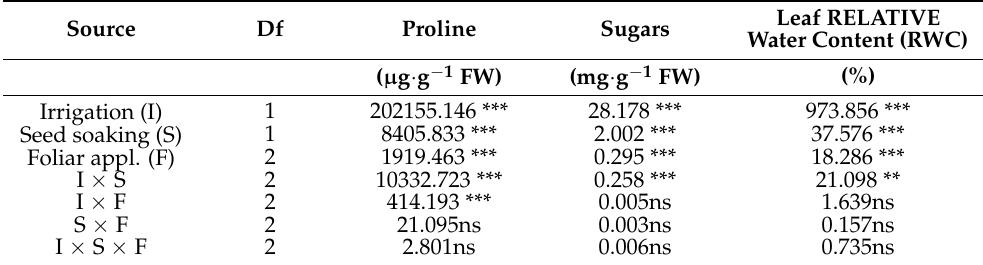
Table 6. Analysis of variance (mean square) of osmolytes and leaf water status.